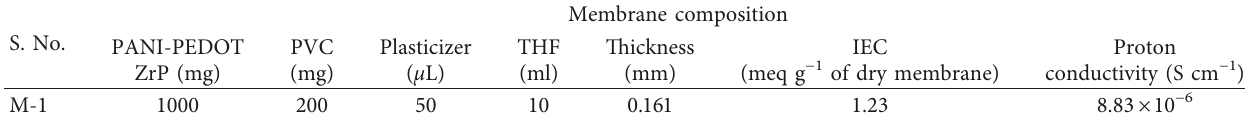
Table 1: Composition, IEC, and PC of the PANI/PVC-PEDOT: PSS-ZrP composite ionomer membrane. S. No.